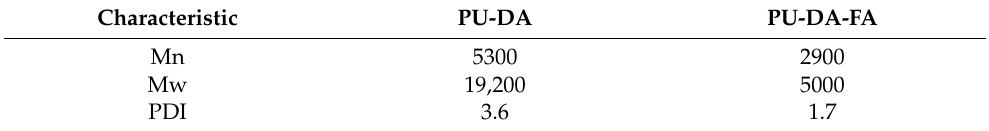
Table 1. Molecular mass characteristics of PU-DA and PU, derived from furan-terminated prepolymer.